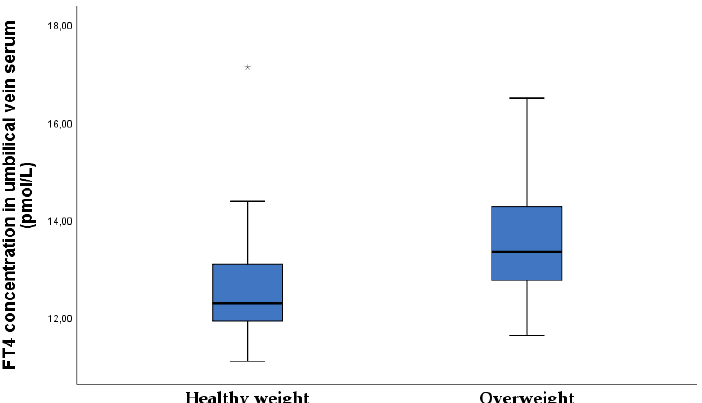
Figure 10. FT4 concentration in umbilical vein serum in healthy-weight and overweight neonates (healthy weight 12.6 ± 1.2: overweight 13.5 ± 1.2, p = 0.010). BMI, BDNF, and TSH increased odds for overweight neonates in the first trimester. Leptin concentration in the first trimesters decreased the odds for overweight neonates (Table 5). Table 5. Odds of the overweight neonate for BMI, HbA1c, leptin, and BDNF in the first trimesters of pregnancy.